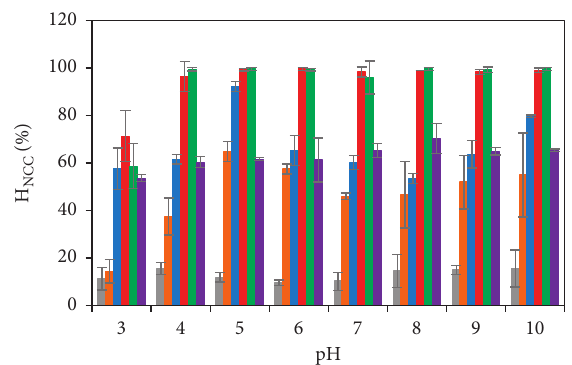
Figure 6: Ionic strength effect on the NCC adsorption onto the α -Al 2 O 3 particles: without PVBTAC modification at ( ) 10mM NaCl and with PVBTAC modification at: ( ) 0, ( ) 1, ( ) 10, ( ) 100 and ( ) 200mM NaCl. Other conditions are C i, NCC of 10 ppm, t of 2 h, and m α -Al2O3 of 5 mg mL − 1 .